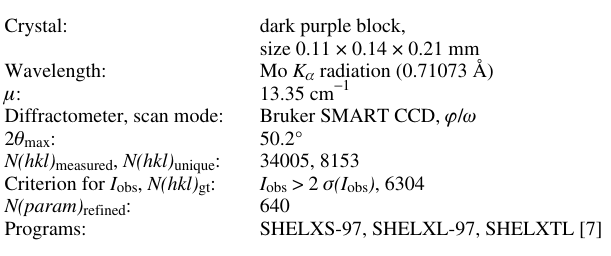
Table 1. Data collection and